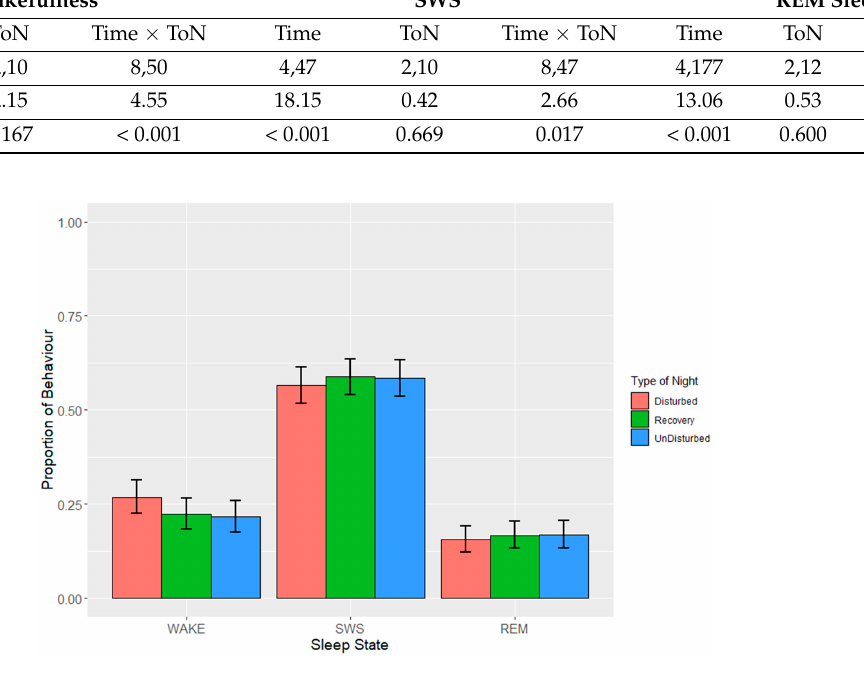
Figure 5. E ff ects during lights o ff of the three di ff erent types of night on proportions of states (wake- fulness (WAKE), slow-wave sleep (SWS) and rapid eye movement (REM) sleep). Values are back- transformed means ± SEs estimated from LMMs fi tt ed to angular transformed proportions.